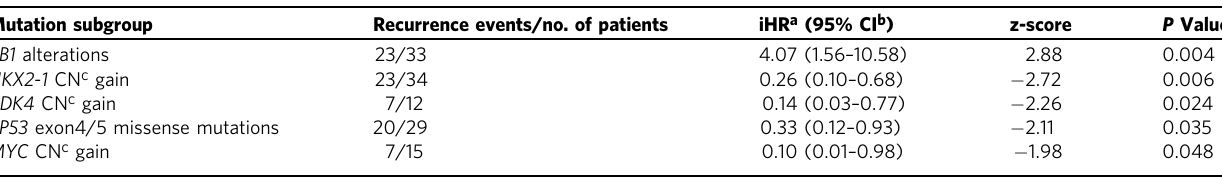
Table 1 Predictive values of different genomic aberrations derived according to disease-free survival (DFS). Predictive markers (treatment-by-gene